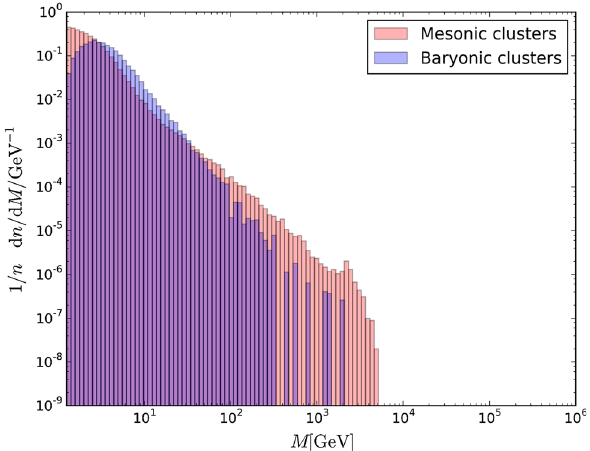
Fig. 18 The invariant mass distribution of mesonic and baryonic clus- ters after colour